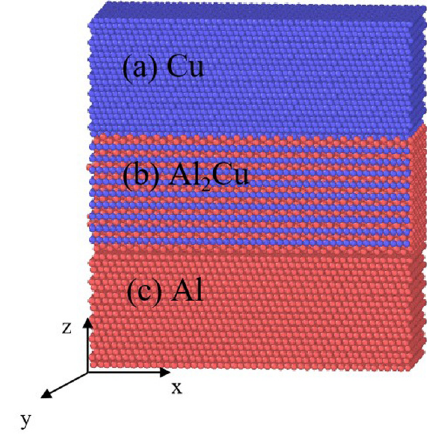
Figure 1. The X and Y - axis directions in the model repre -